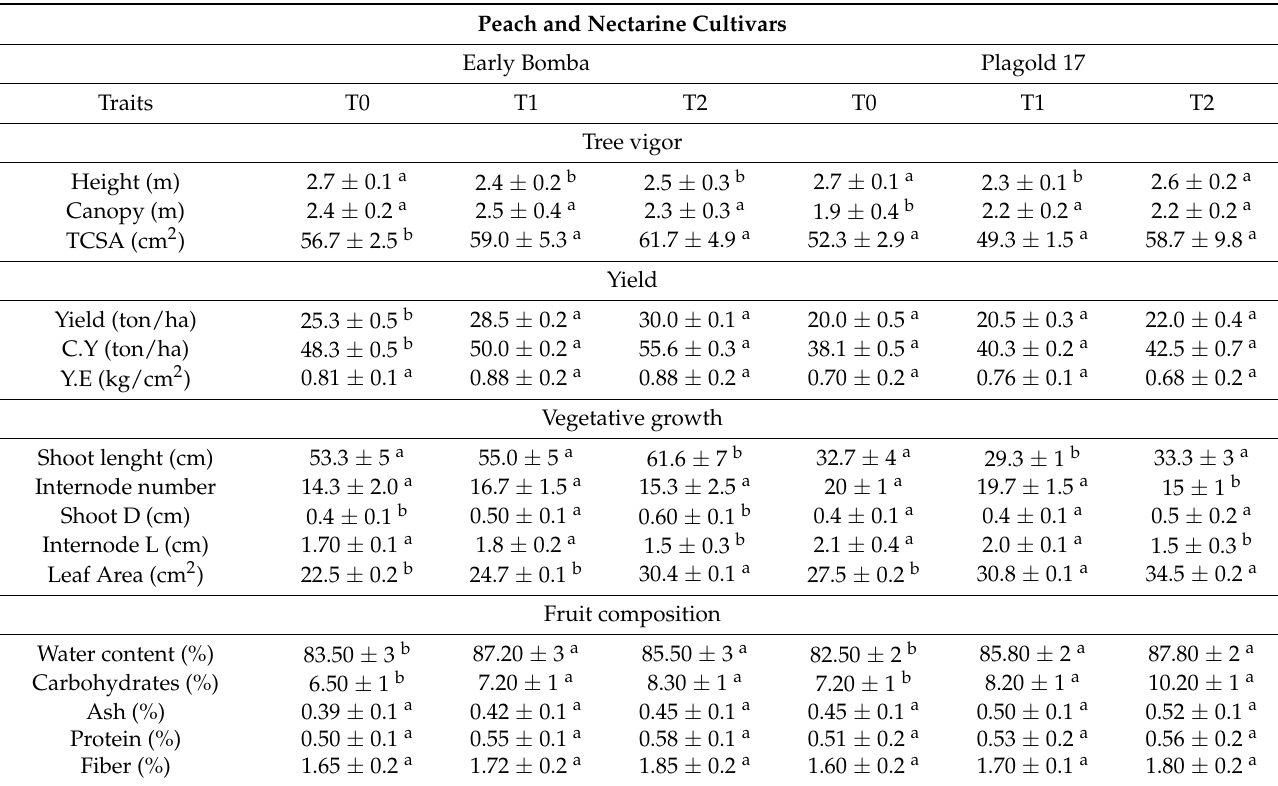
Table 3. Impact of potassium silicon treatments on tree vigor, vegetative growth, and fruit nutritional composition (%) for the peach and nectarine cultivars during two growing seasons. Values are means of three measurements ± SE. Mean separation within columns by Scheffe’s multiple range tests ( p ≤ 0.05). In each row, within each cultivar, values with the same letter are not significantly different. Peach and Nectarine Cultivars Early Bomba Plagold